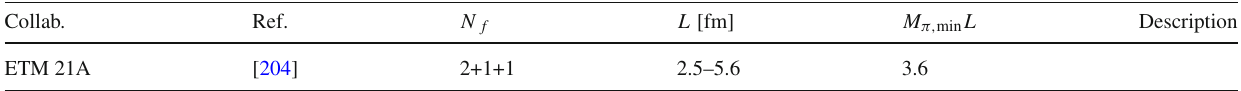
Table 83 Finite-volume effects in determinations of m ud , m s and, in some cases m u and m d , with N f = 2 + 1 + 1 quark flavours Collab. Ref.